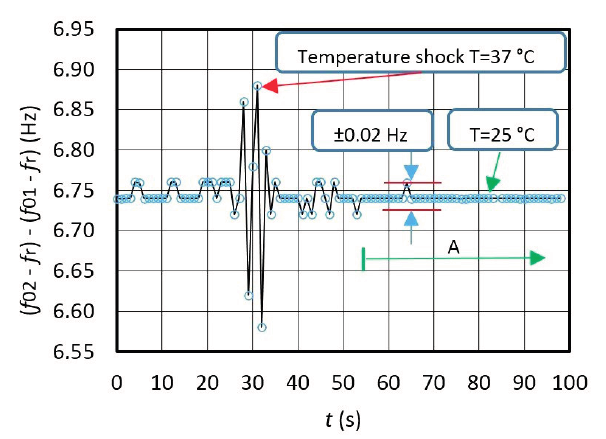
Figure 8. Output frequency dynamic variation of f out during the change of temperature from 25 °C to 37 °C and back to 25 °C (measurement time: 0–100 s, f out = f 02 − f 01 , L x = 85.001 µH, L ref = 85